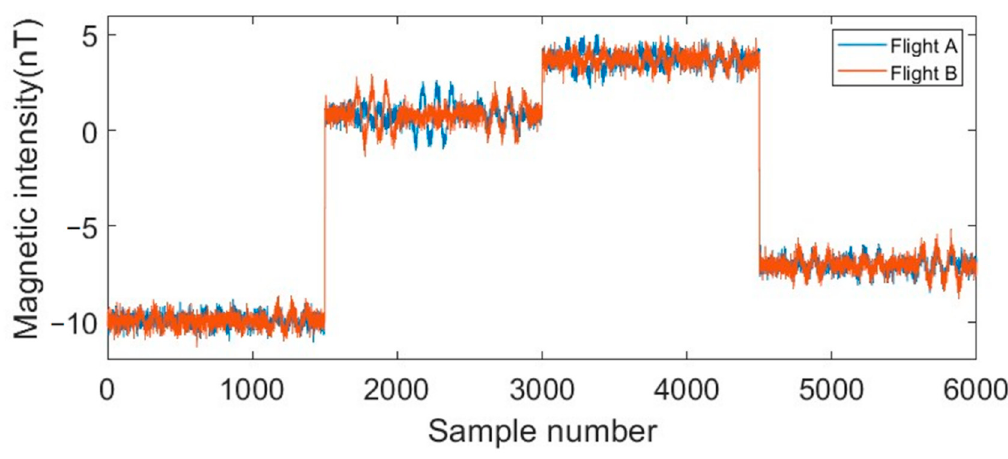
Figure 6. Aeromagnetic interference model corresponding to FOM flight.